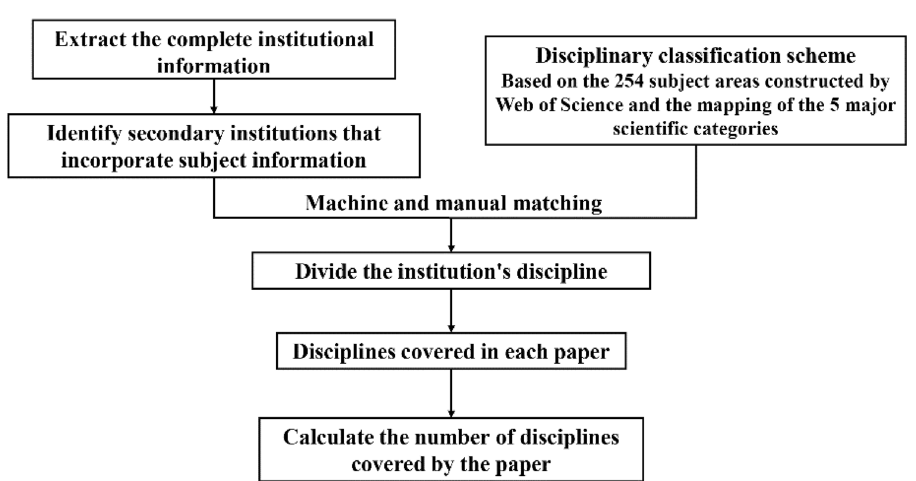
Figure 3. Procedure for measuring knowledge diversity in interdisciplinary